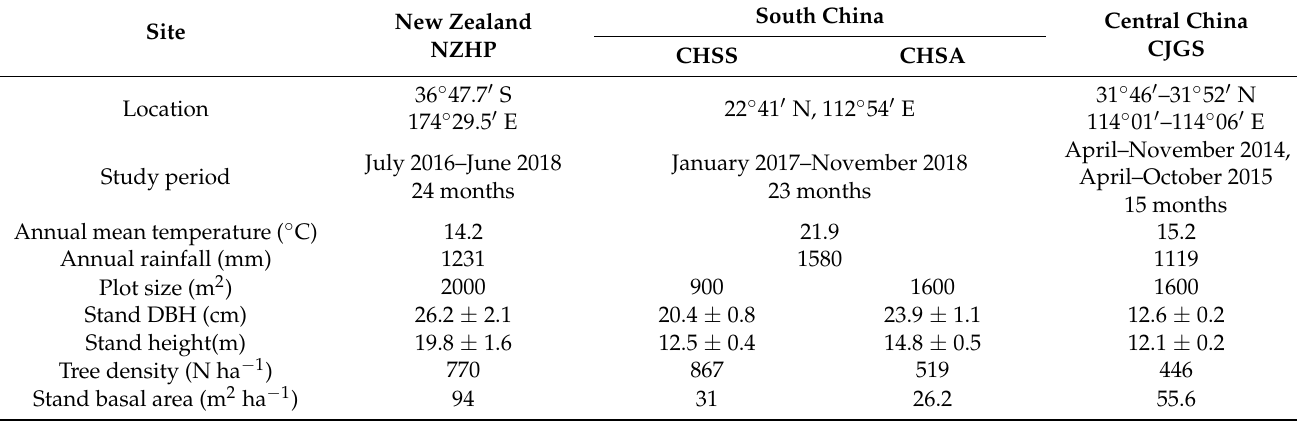
Table 1. Details of study sites including location, study period, climate and forest characteristics with trees ≥ 3 cm DBH at each stand. The presented values are means ± SE.